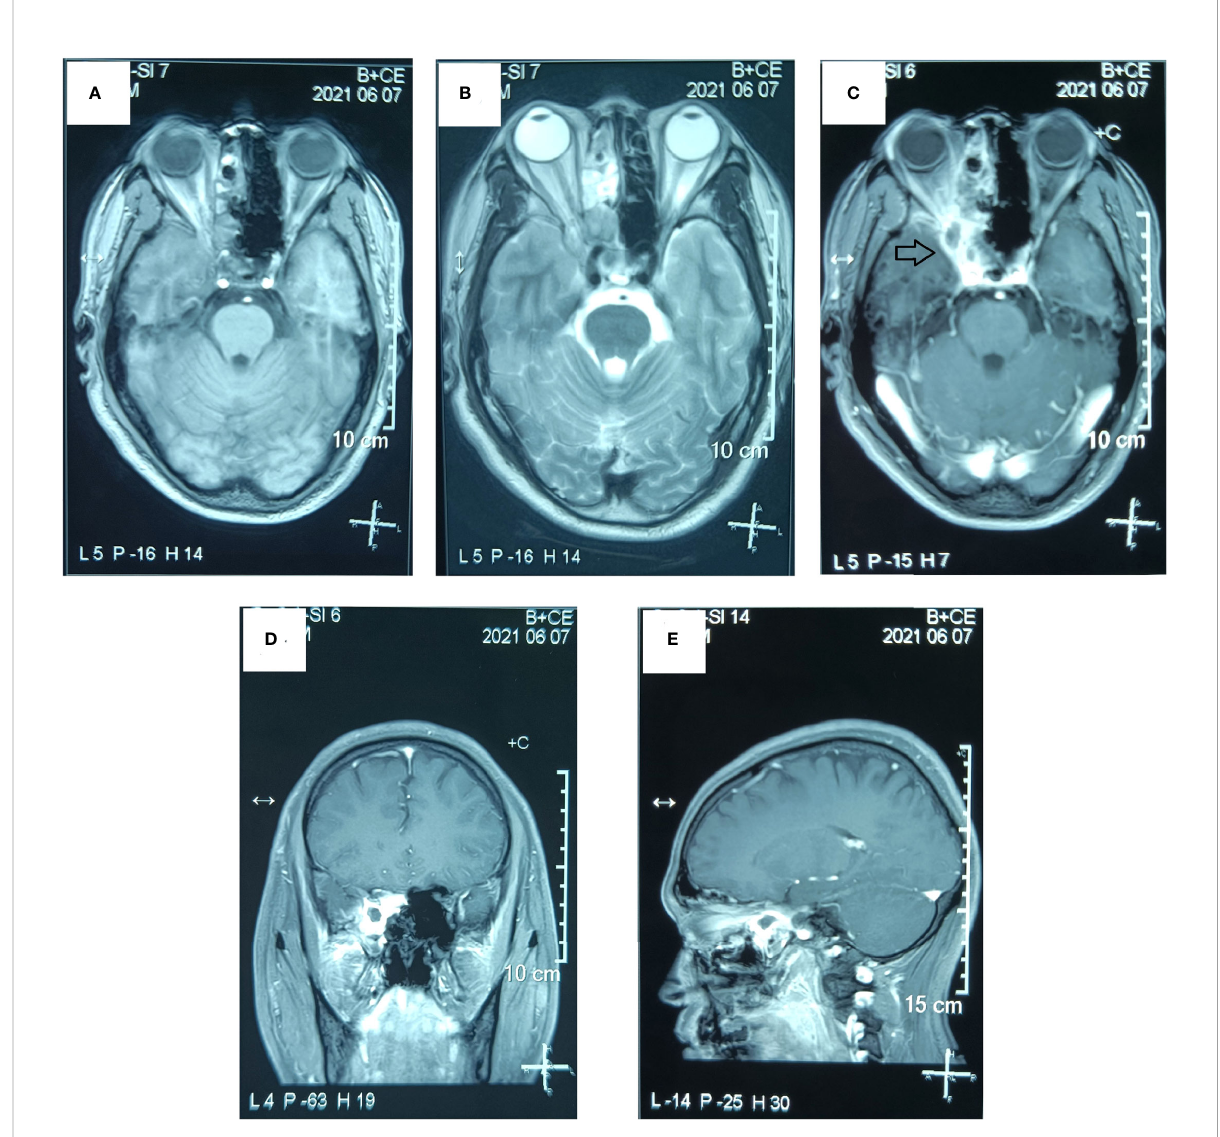
FIGURE 5 Postoperative MR examination of the paranasal sinus. The MR examination detected a residuary tumor in the surgical area and the lateral side and the tip of the right orbit. (A) Axial T1-weighted image. (B) Axial T2-weighted image. (C) Axial T1-weighted enhanced image. (D) Sagittal T1-weighted enhanced image. (E) Coronal T1-weighted enhanced image. (The mass is marked with a black